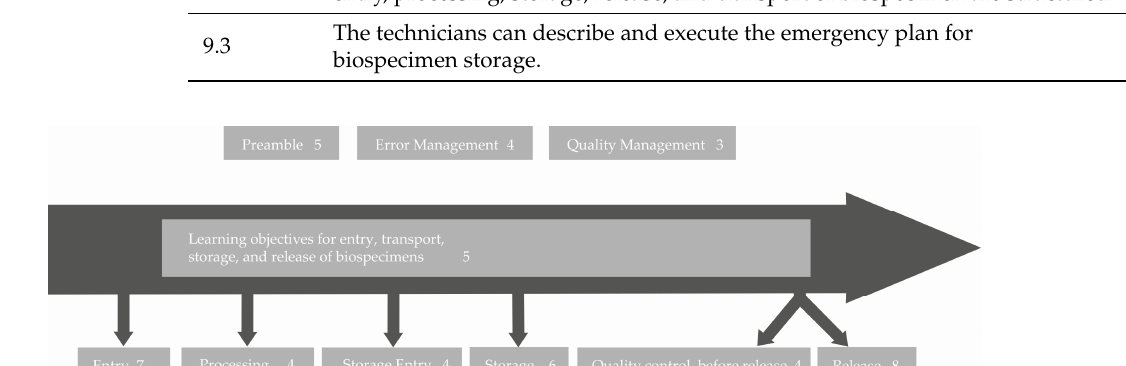
Figure 3. ( A ) Evaluation of seven presented biobank topics by the technical personnel. ( B ) Estima- tion of the coworkers of the technical personnel on how many of their technicians would need advanced training in the presented biobank topics.